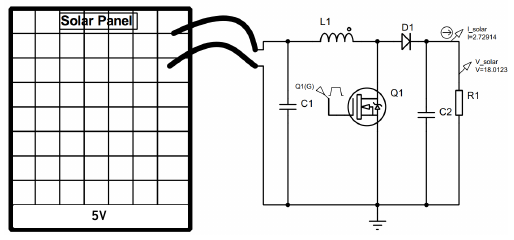
Figure 7. The scheme of the stand-alone harvesting solar energy In the Fig. 7, the output current of the solar system is 2.73 A and the voltage is 18.01 V. The output voltage of the boost converter is much higher than 5 V, but the result is fluctuating and especially, this value is not proper with the charging voltage of the battery 6S Li- po.